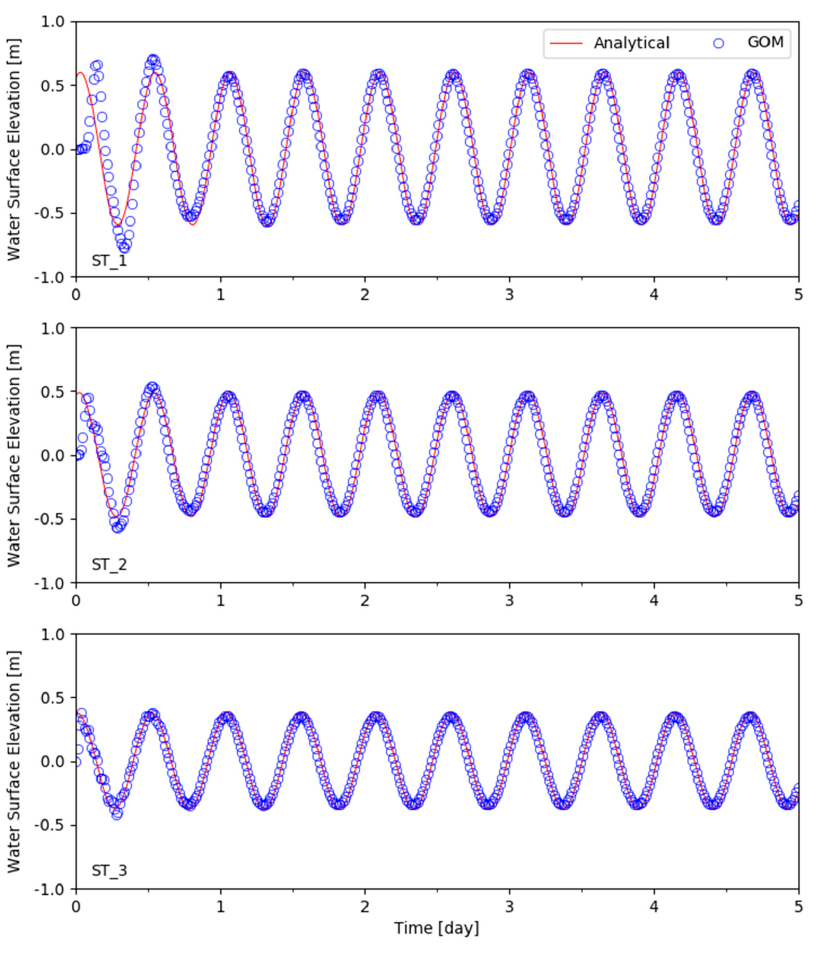
Figure 13. Comparison of water surface elevation for the Quarter Annular test case at three di ff erent locations. Solid lines and circles represent analytical solutions and numerical results, respectively.